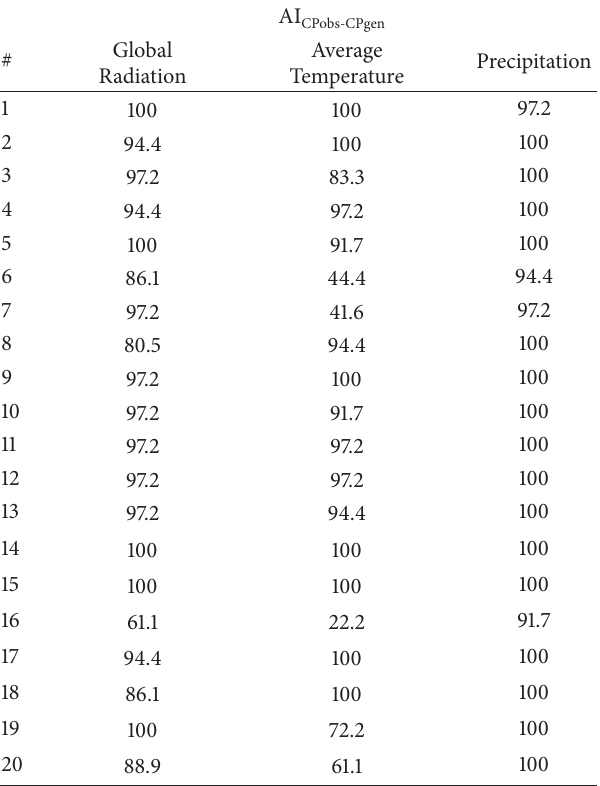
Table 3: Acceptability indices obtained when the observed weather series were compared to the generated series for central points of the investigated polygons. The parameters for generating artificial weather data were obtained by spatial interpolation using the data of the border points.